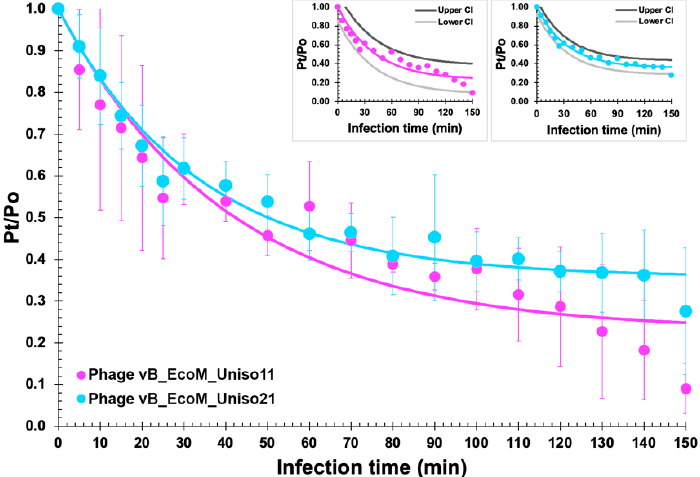
Figure 3. Adsorption curves of phages vB_EcoM_Uniso11 and vB_EcoM_Uniso21 particles onto E. coli CCCD-E003 host cells, allowing to calculate the phage particles adsorption rate following non-linear fitting of the logarithmic function to the experimental data. Values are the means of three independent assays; error bars represent the standard deviations.